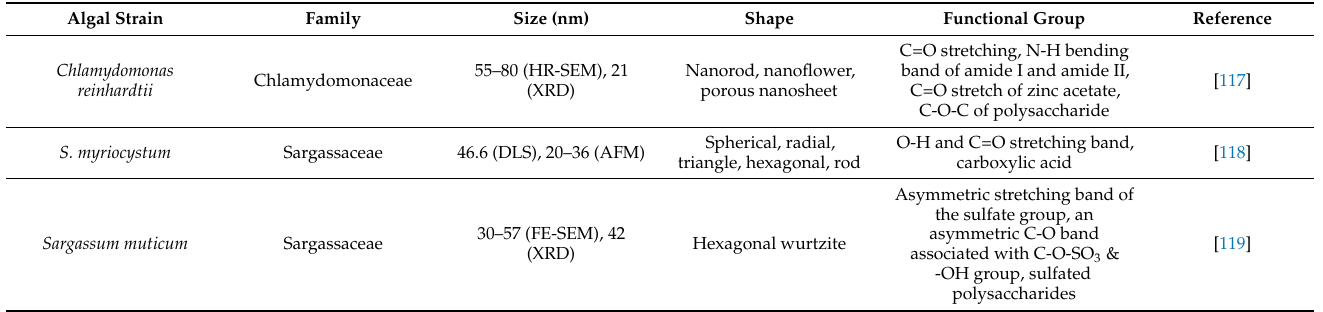
Table 3. Synthesis of ZnO-NPs using